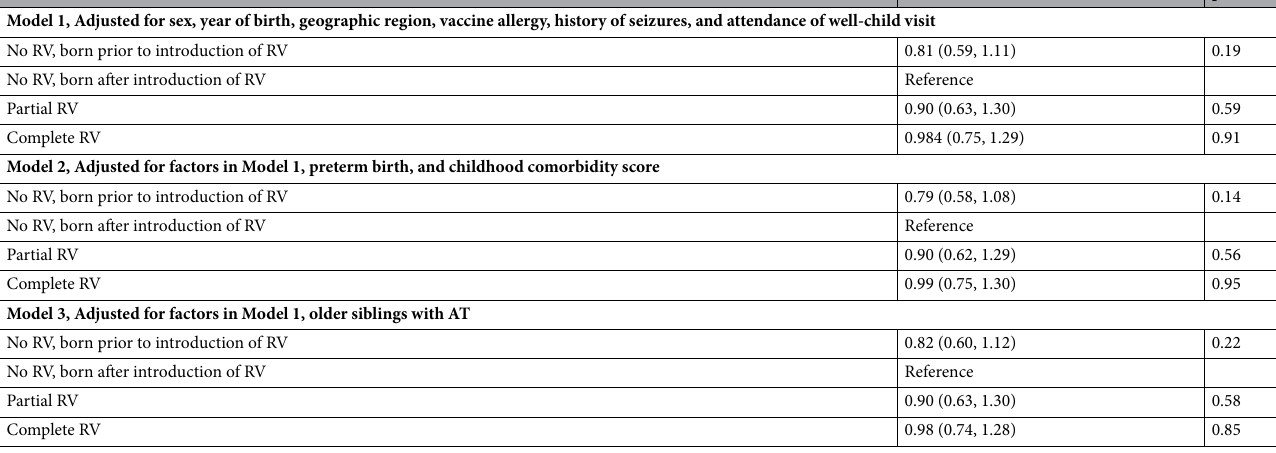
Table 3. Risk of autoimmune thyroid disease by rotavirus vaccination (RV)